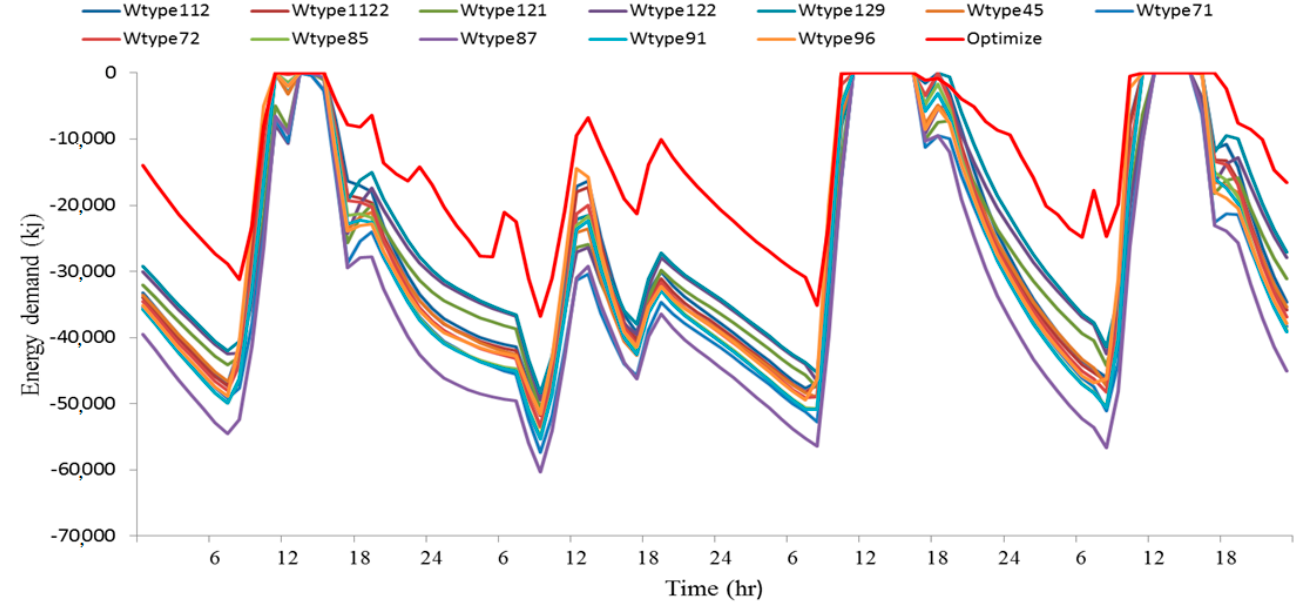
Figure 10. The amount of heat demand in the optimized and other types of passive solar greenhouse.